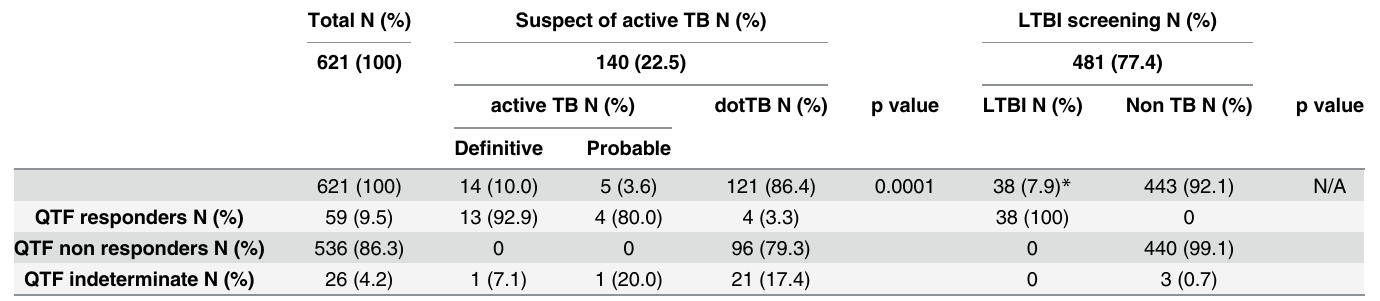
Table 2. QuantiFERON TB Gold in tube (QFT-IT) results as a function of the